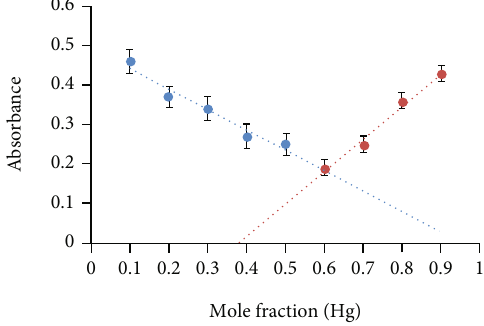
Figure 8: Job ’ s plot to observe binding stoichiometry of ACR- AgNPs complex with Hg 2+ .